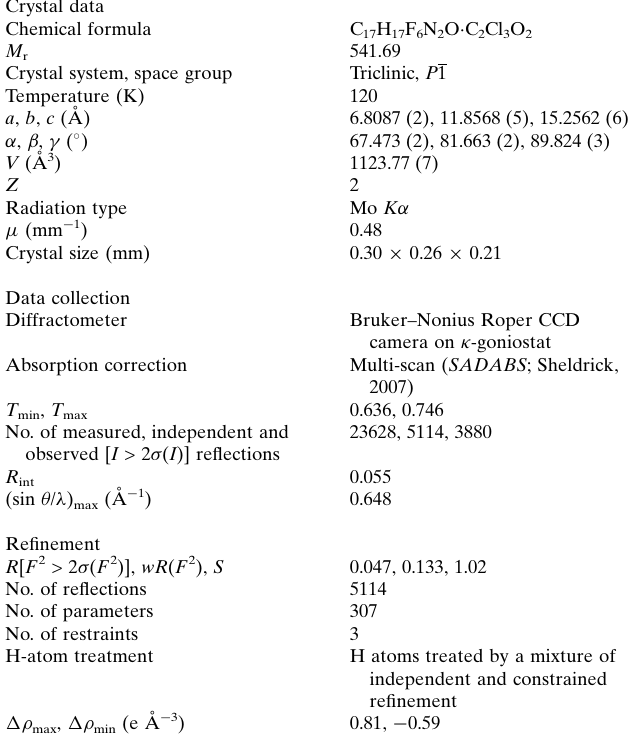
Crystal data Chemical